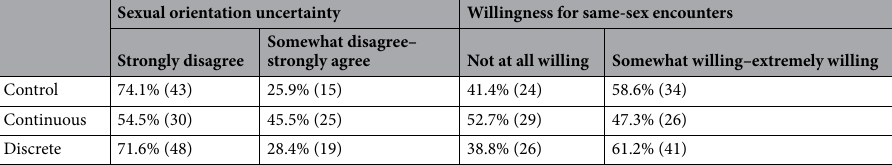
Table 2. Study 1. Post-manipulation ratings of sexual orientation uncertainty and willingness for same-sex encounters in control, continuous, and discrete conditions.